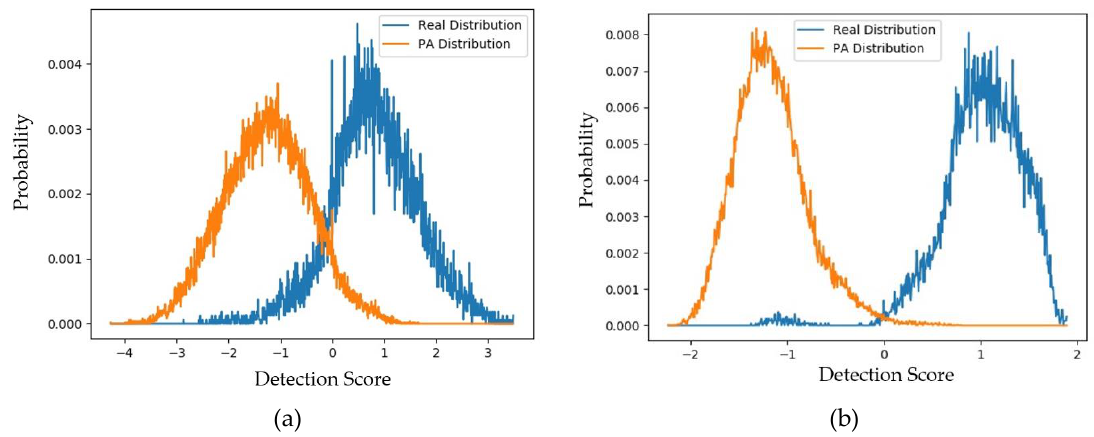
Figure 8. Distribution of detection scores for the original captured data (captured real and captured PA images): ( a ) results obtained using handcrafted-based face-PAD system [50]; ( b ) results obtained using deep-learning-based face-PAD system [15].